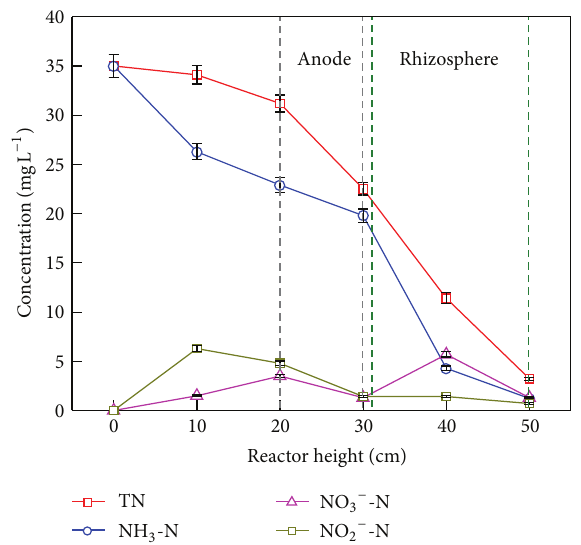
Figure 6: The change of different forms of nitrogen in the planted CW-MFC.